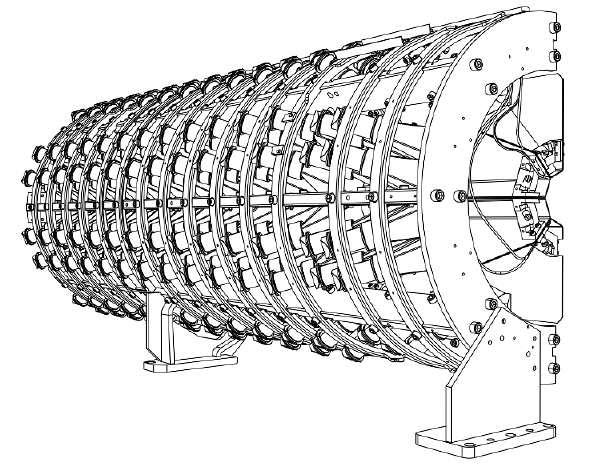
Figure 1 . A schematic drawing of one half of the CASTOR calorimeter and its mechanical support structure. The diameter of CASTOR is roughly 0.6 m and it is approximately 1.6 m in length. The transversal and longitudinal segmentation in eight sectors and fourteen modules, respectively, can be clearly distinguished. The 112 small cylinders represent the photomultiplier tubes of CASTOR. These are mounted on light guides, which transport the Cherenkov radiation out of the detector. It may be observed that CASTOR has only transverse and no (cid:17)